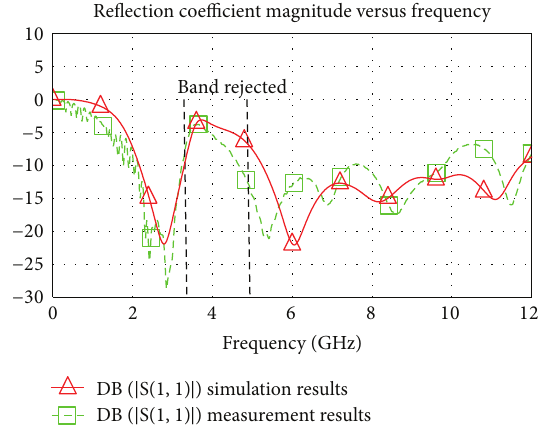
Figure 4: Simulation and measurement of return loss of the antenna when the switch is OFF and the slot generates a notch from 3.5 to 5GHz.